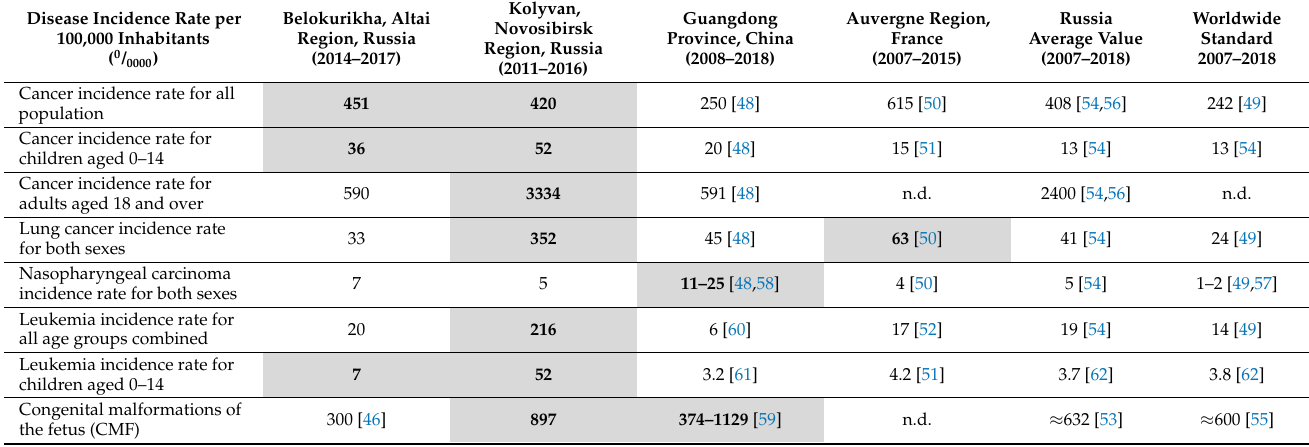
n.d.—no data. The bold lettering and gray-colored boxes represent increased incidence rates relative to Russia and worldwide average values. Source of data in square brackets [